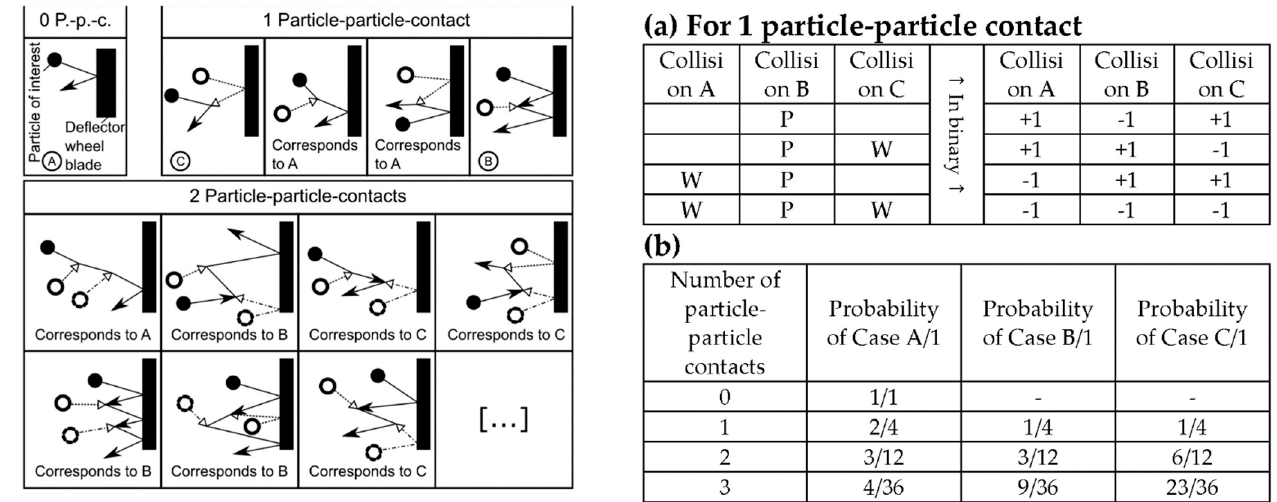
Figure 12. Theoretical classification of particle–wall and particle–particle interactions for 0, 1, and 2 particle–particle contacts (P.-p.-c.). Table a shows the conversion from particle–deflector wheel paddle collision (W) and particle–particle collision (P), exemplary for one particle–particle contact. Table b lists the probabilities for Cases A, B, and C calculated by permutation and filtering of unrealistic combinations.